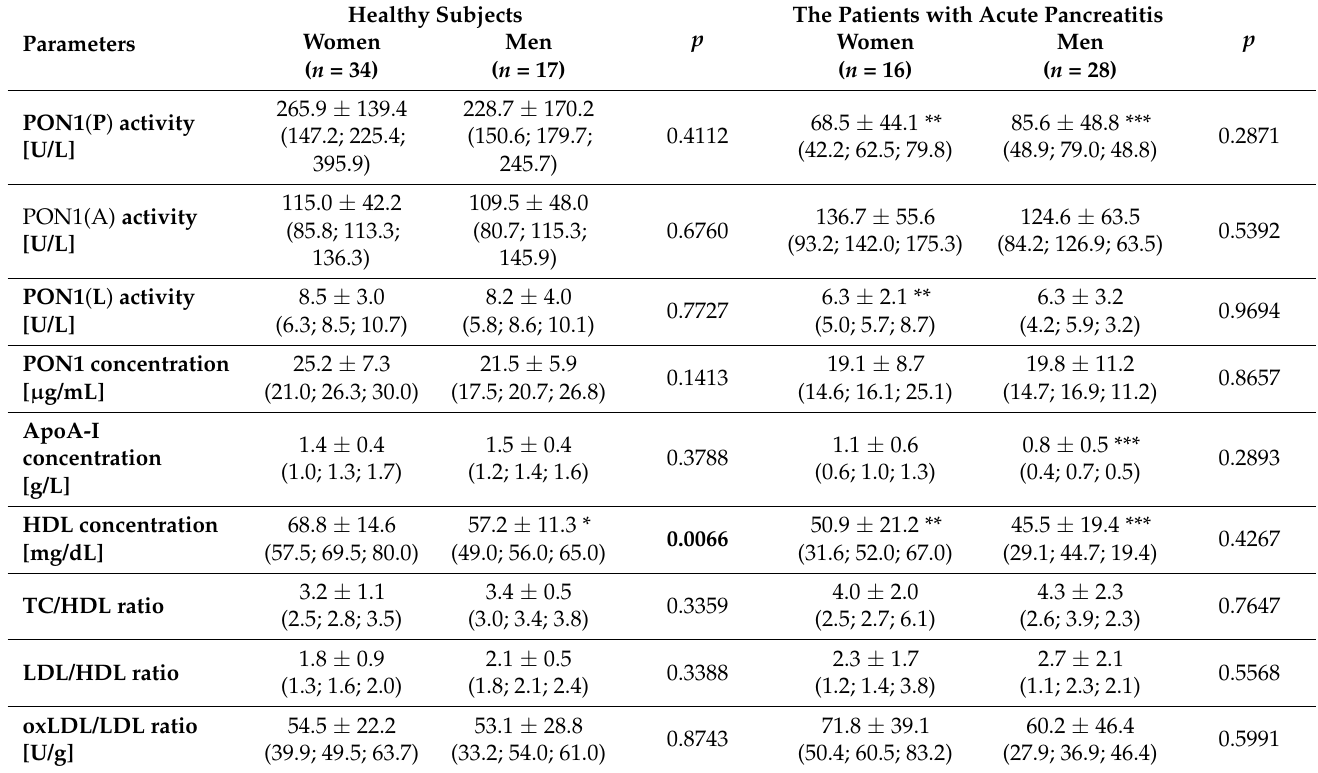
Table 2. The activities of PON1, its concentration, the concentration of apoA-I, lipid profile parameters, and selected markers of pro/antioxidative balance in the context of intersexual variability in the group of healthy subjects and AP